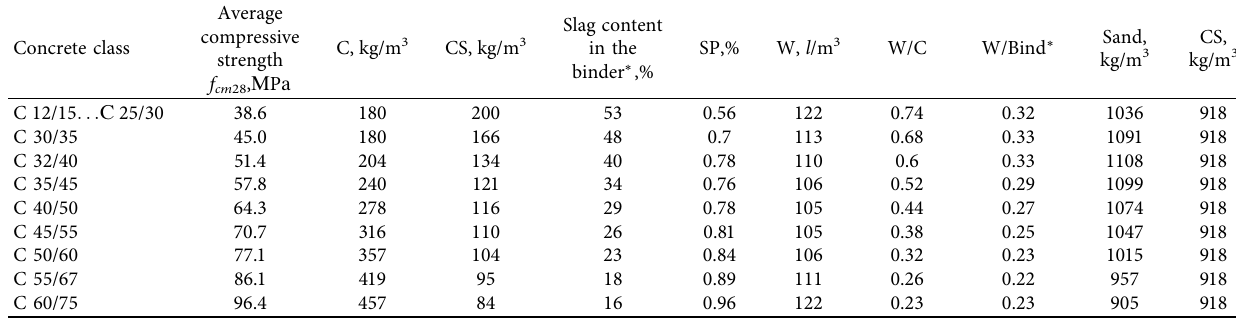
Table 9: Optimization results according to Task 2.